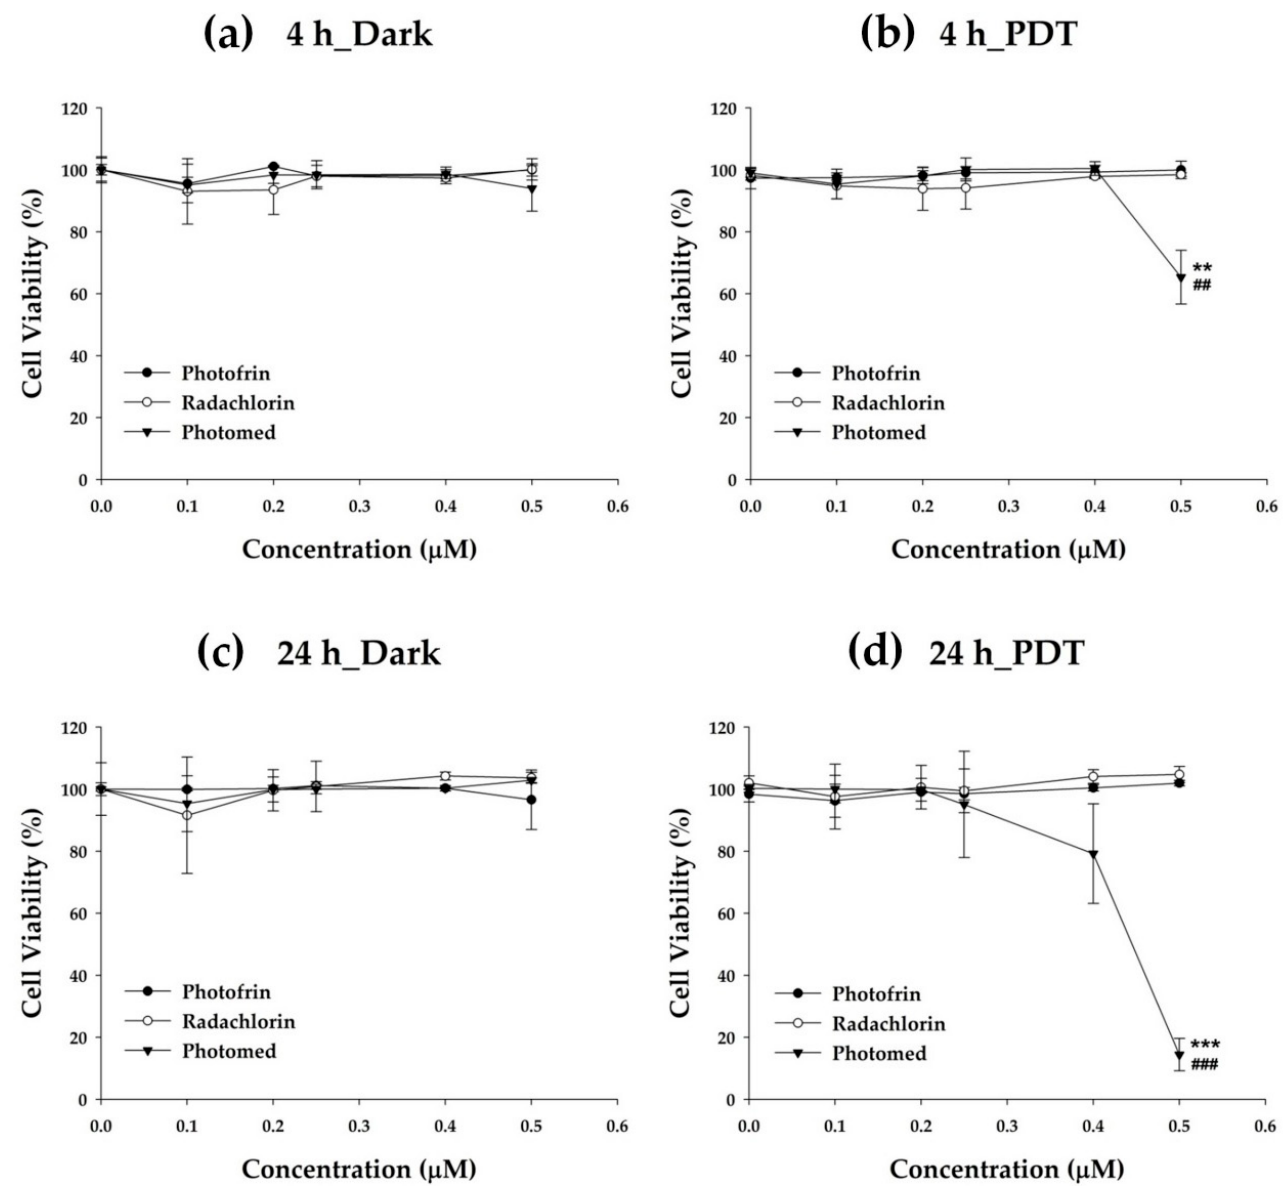
Figure 4. In vitro viability of SCC VII cells after various concentrations (0, 0.1, 0.2 0.25, 0.4 and 0.5 µ M) of Photofrin, Radachlorin and Photomed treatment. ( a ) 4 h incubation of photosensitizers followed by no irradiation. ( b ) 4 h incubation of photosensitizers followed by light irradiation (PDT). ( c ) 24 h incubation of photosensitizers followed by no irradiation. ( d ) 24 h incubation of photosensitizers followed by light irradiation (PDT). Data are presented as means ± SD ( n = 3). ** p < 0.01, *** p < 0.001, Photofrin vs. Photomed. ## p < 0.01, ### p < 0.001, Radachlorin vs. Photomed.